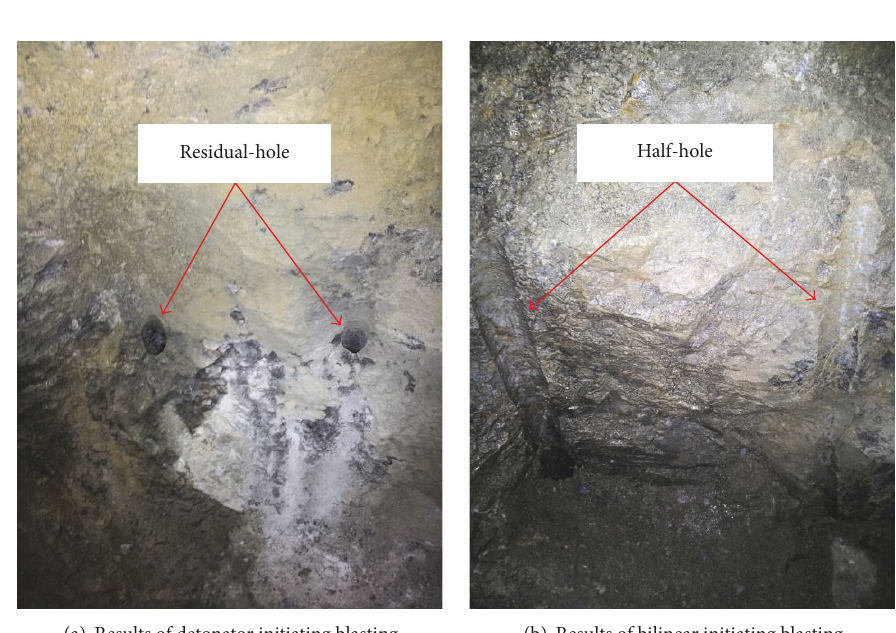
Figure 9: Blasting footage and half-hole of the field